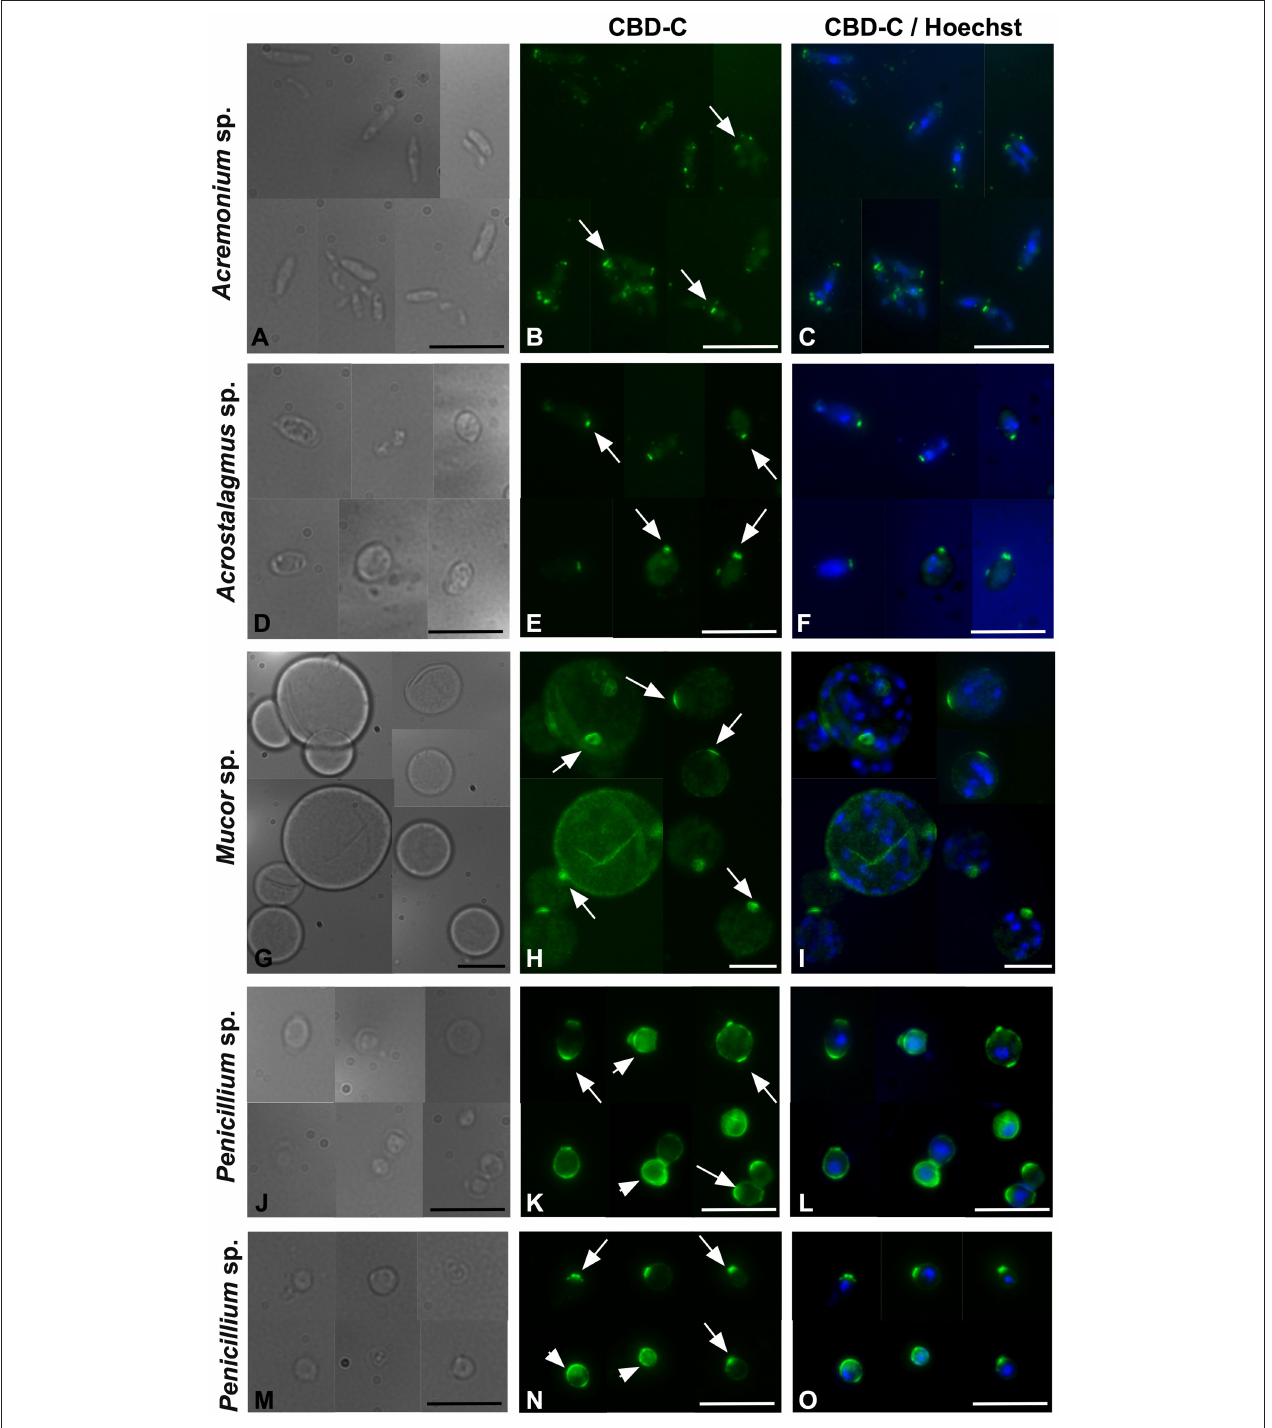
FIGURE 4 | Immunofluorescence with the Fc-CBD-C probe on fungal spores. In Acremonium sp., Acrostalagmus sp., and Mucor sp. the CBD-C probe detects chitin fibers in regionalized areas on the surface of spores isolated from liquid cultures ( B,E,H, arrows). In Penicililum spp., CBD-C binds almost the entire spore wall ( K,N , arrowheads) in most spores. In some spores, chitin is instead detected in localized spots ( K,N , arrow). (A,D,G,J,M) represents brightfield images; (C,F,I,L,O) represent merged images of the Fc-CBD-C probe (green) and nuclear staining with Hoechst (blue). Scale bars: 10 µ m.